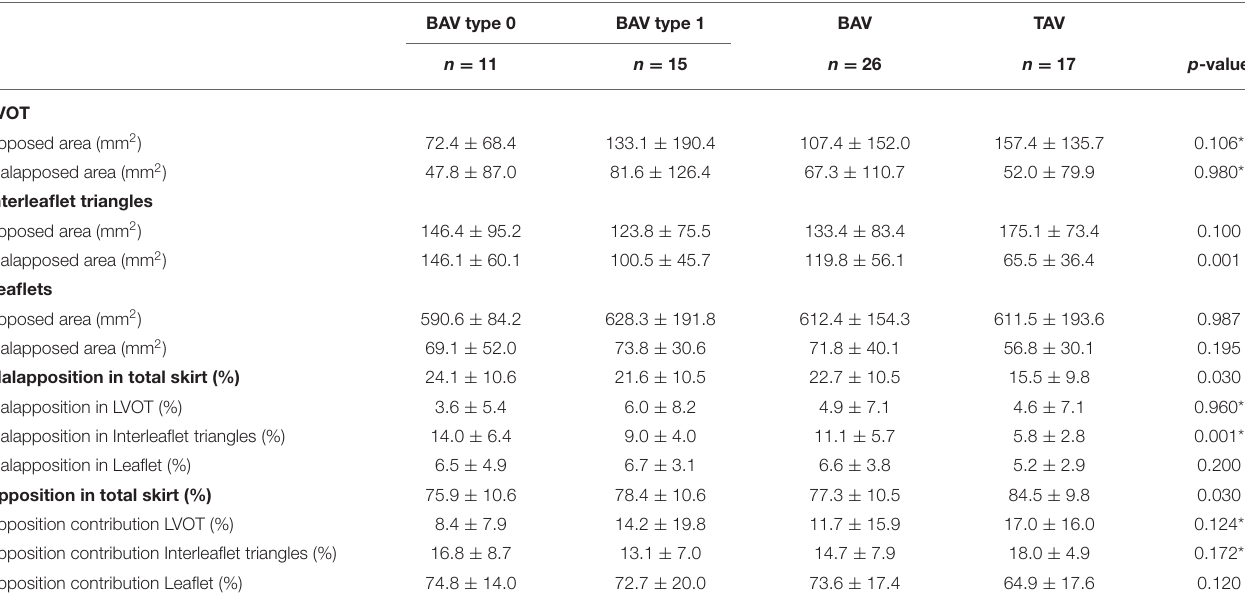
TABLE 3 | Overview of sealing analysis data for the different valve